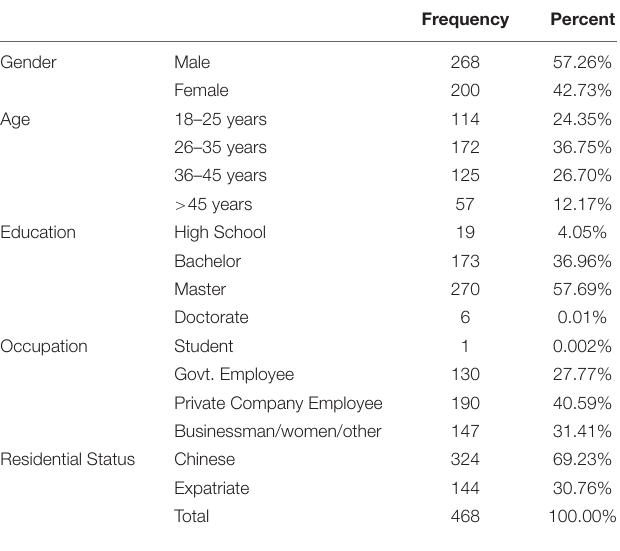
TABLE 1 | Demographic profile of the